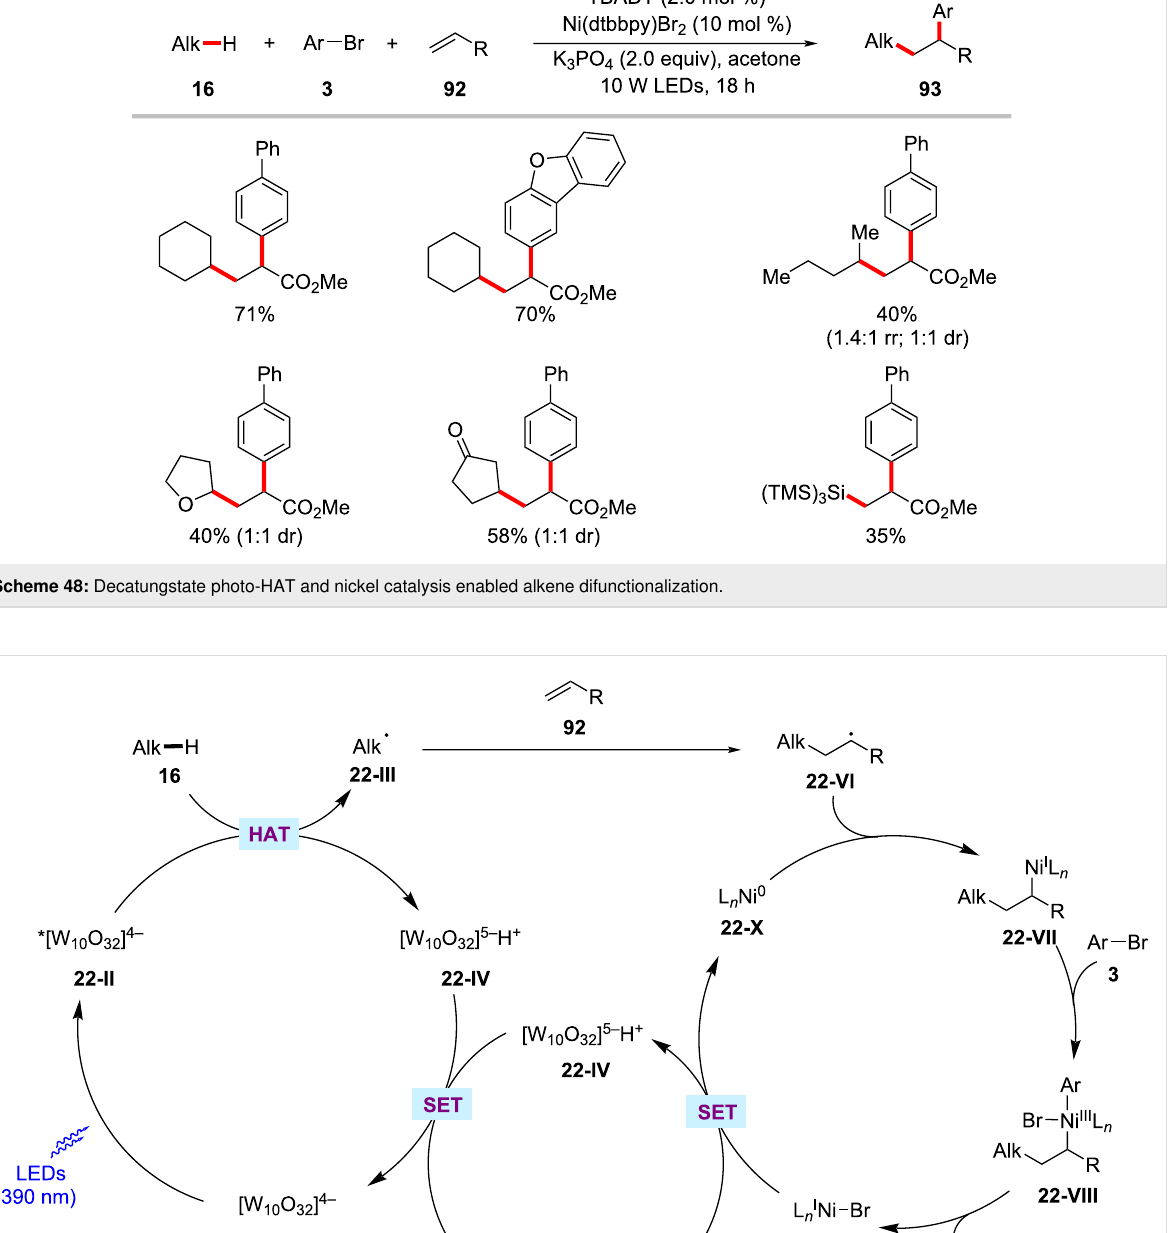
proposed reaction mechanism has two synergistic catalytic cycles, namely a photocatalytic cycle and a nickel catalytic cycle (Figure 23). The photoexcitation of the ketone PC 96 results in the triplet-state diradical 23-I . A HAT process be- tween 23-I and the alkane substrate generates the desired